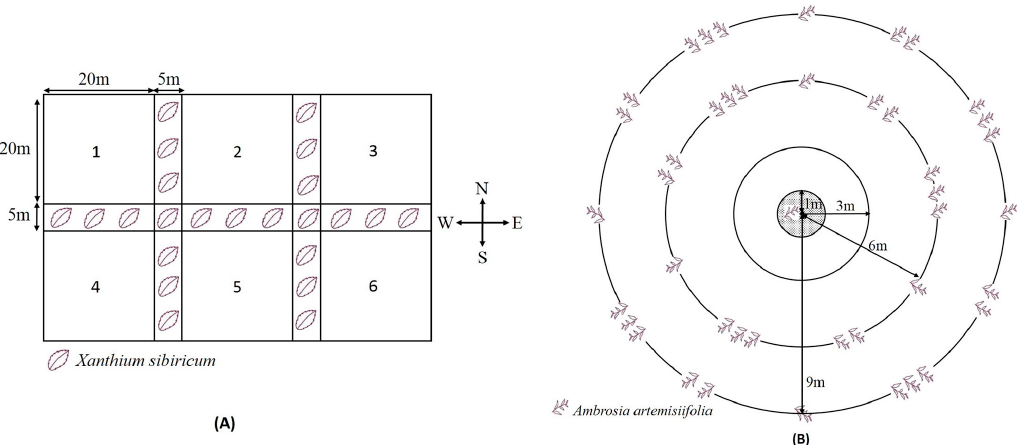
Figure 2. ( A ) Arrangement of experimental plots and ( B ) the planting pattern for the Ophraella communa host-plant selection behavior test on regularly distributed ragweed patches in sunflower plots. The shaded area indicates that 20 ragweed plants were evenly planted in the center (a radius of 1 m) of each plot. “ m and 9 m radius homocentric rings in each plot.